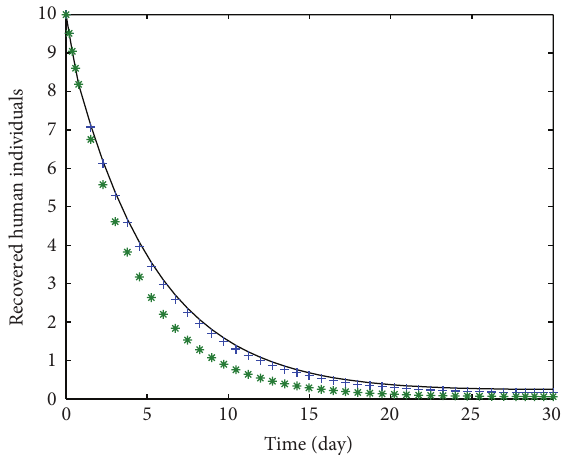
Figure 8: Recovered human: solid line 𝛼 = 1.0 , ++ line (𝛼 = 0.95) , and ∗∗ line (𝛼 = 0.90) .